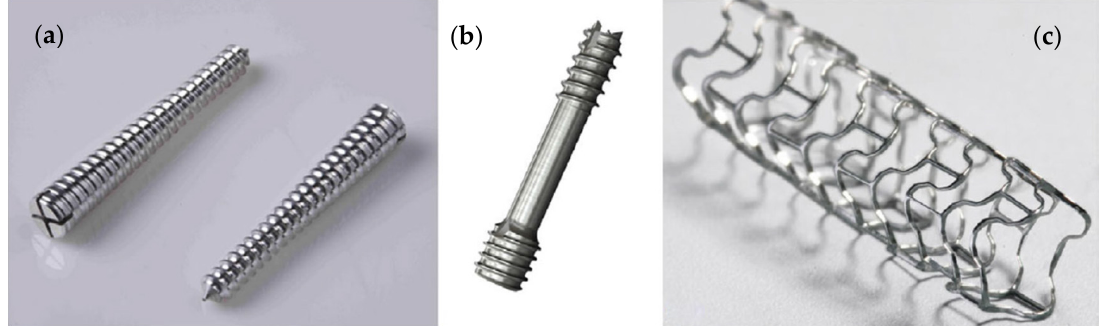
Figure 1. Examples of biodegradable metal implants: ( a ) headless screws developed by U&I Corporation, Korea, ( b ) compression screw from a German company; and ( c ) a biodegradable stent designed by a German company [2].